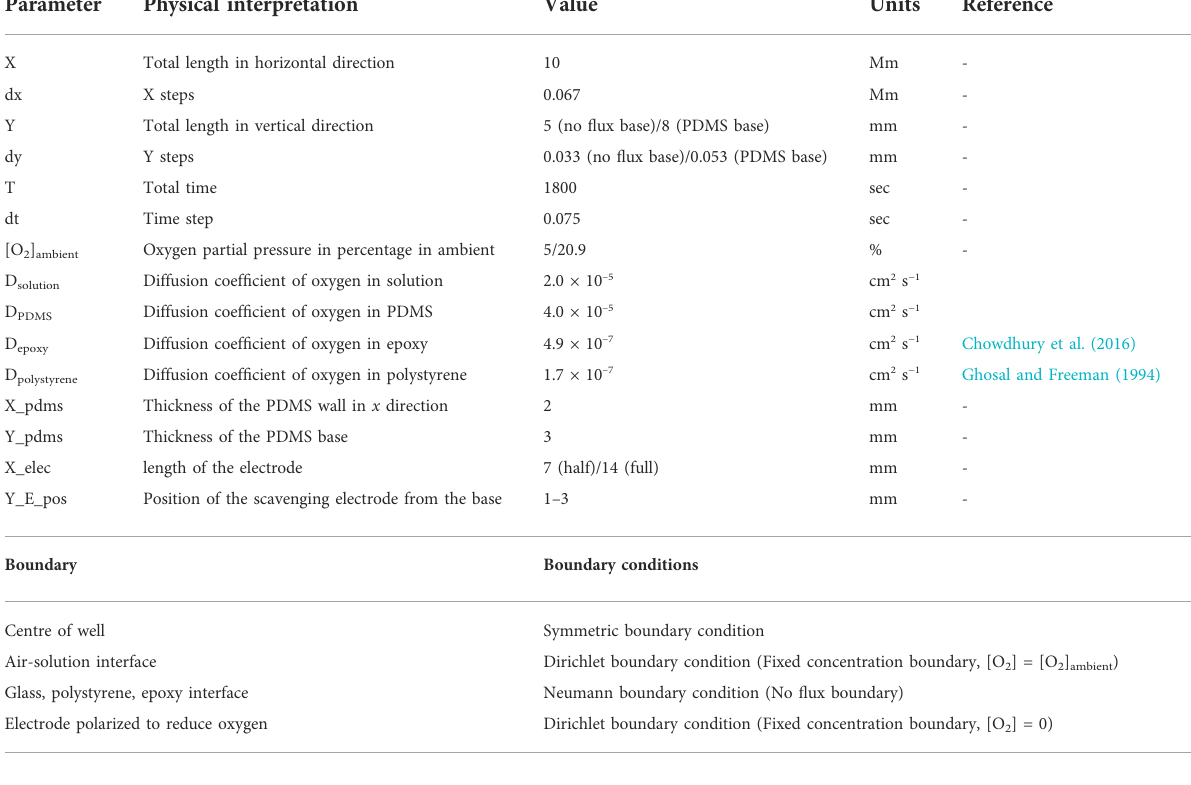
TABLE 1 Parameters used for